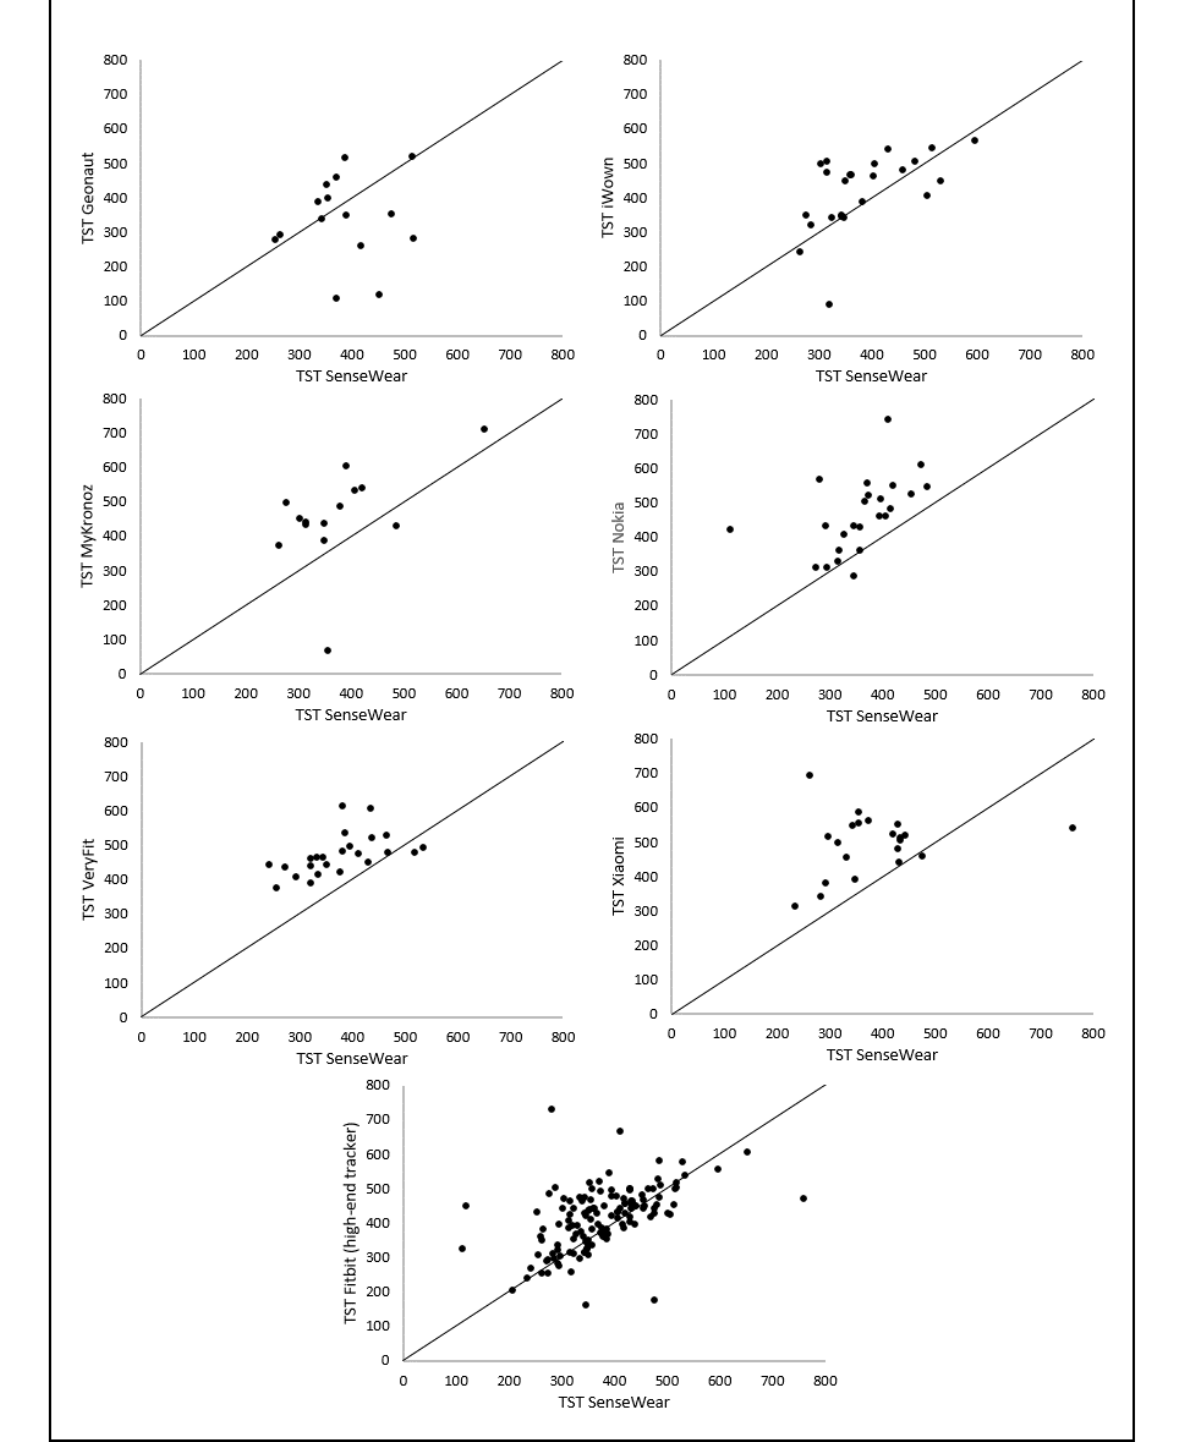
Figure 7. Correlations between total sleep time estimates from the trackers and the